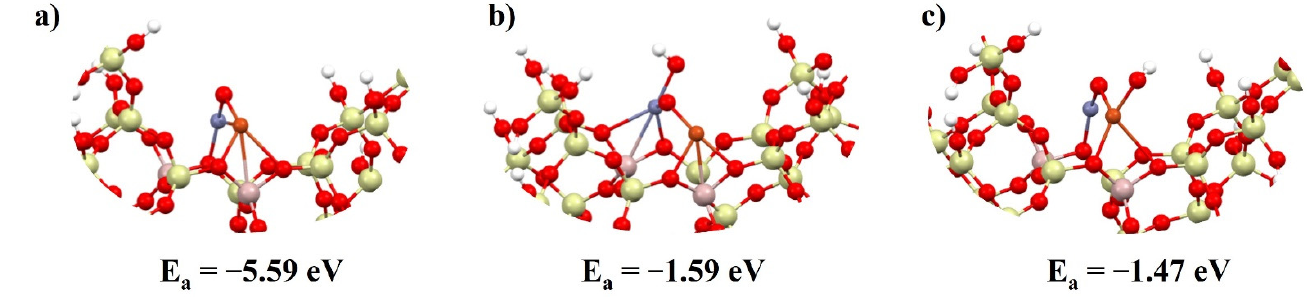
Figure 2. Cluster model of FAU zeolite structure with deposited bimetallic dimer ( a ) copper–zinc dimer, ( b ) copper–zinc dimer with hydroxyl group adsorbed on zinc, and ( c ) copper–zinc dimer with hydroxyl group adsorbed on copper, with adsorption energy below the structure. Zn (blue), Cu (orange).